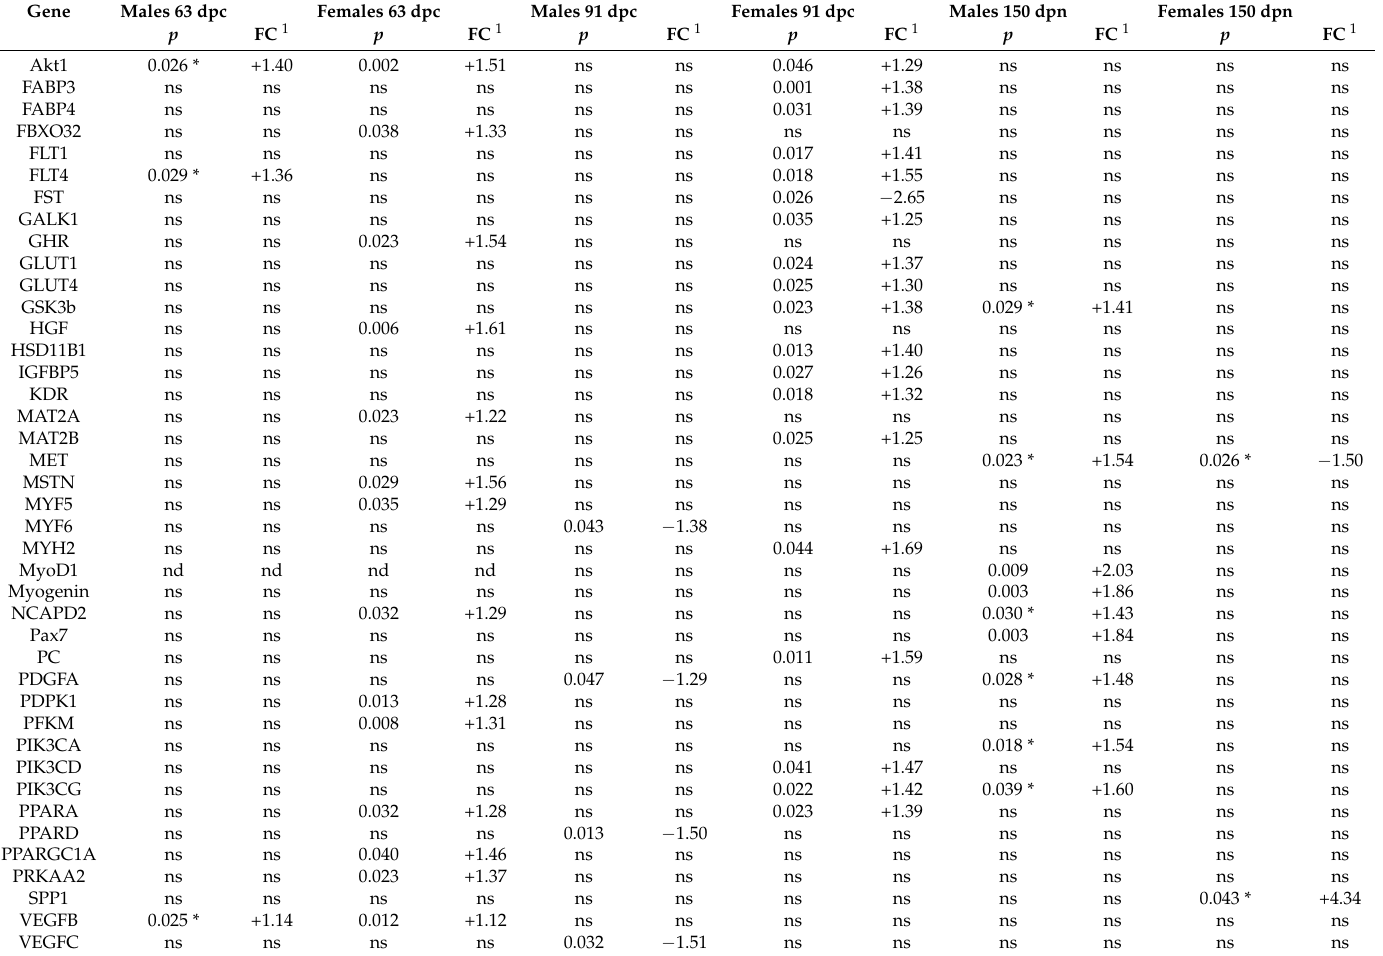
Table 2. Transcripts affected by diet and sex at prenatal and postnatal time points (excerpt from Table